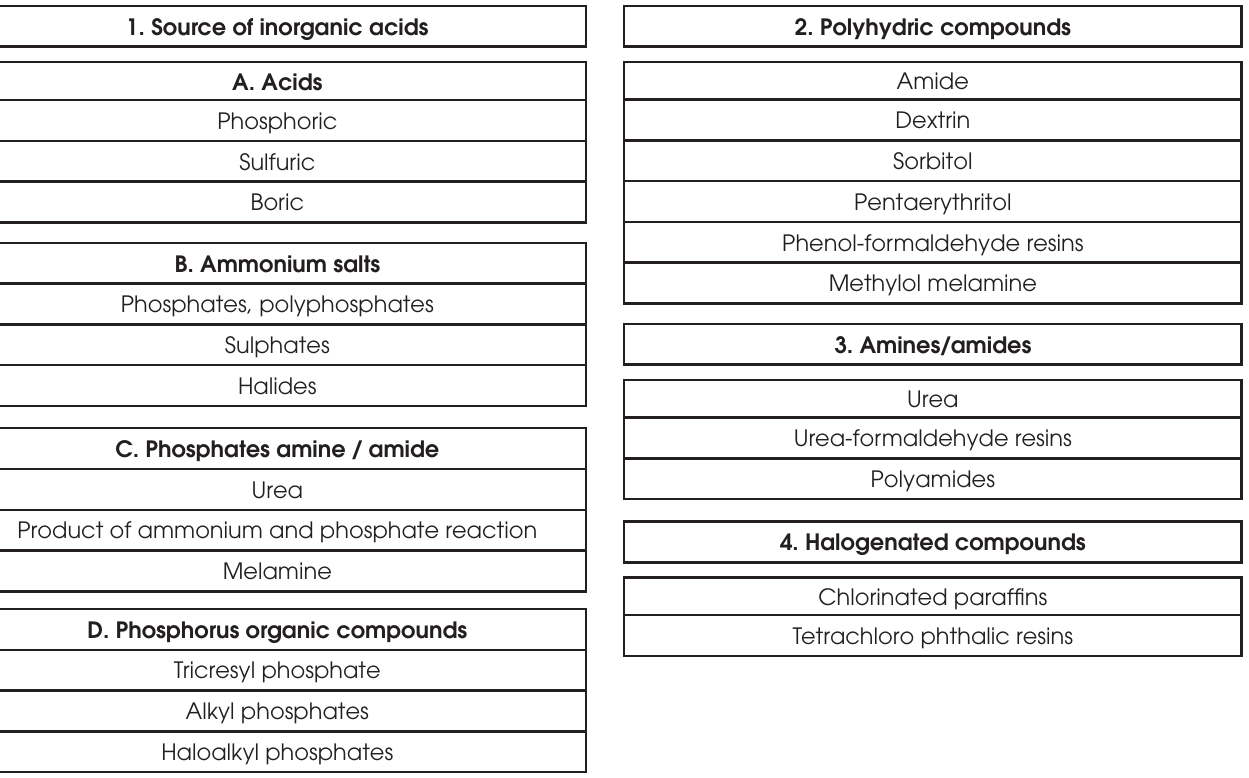
Examples of materials that meet the formulation of intumescence (Source: Vandersall apud Camino et al